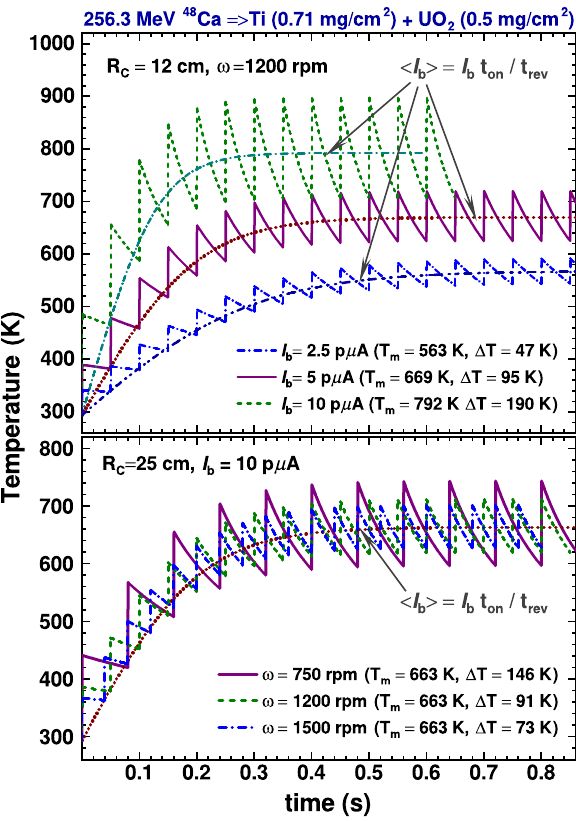
FIG. 9. Time-dependent temperature variations for a rectangu- lar beam shape and uniform beam-density distribution are shown (different lines). These are the results of calculations (similar to Refs. [5,8,11]) for rotating targets with different central radii R c , angular velocities ω , and beam intensities I b .